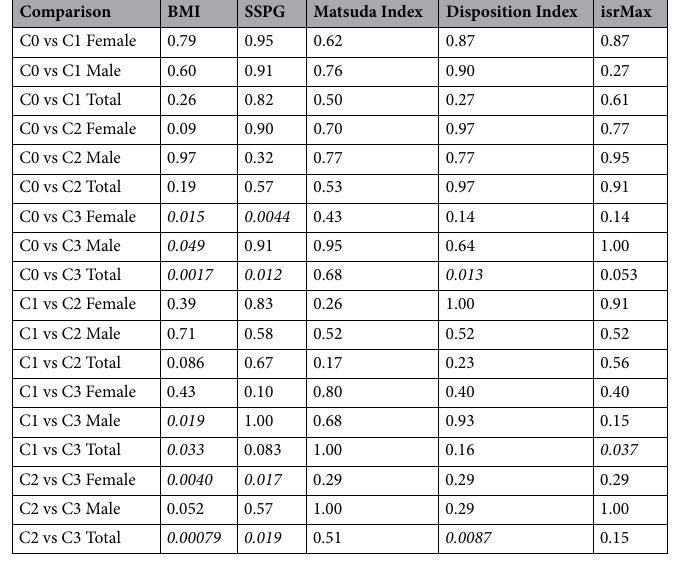
Table 3. Mann–Whitney U test for different measures between two different communities. The labels C0, C1, C2,C3 correspond to Community 0, Community 1 Community 2 and Community 3, respectively. Statistically significant ( p value < 0.05) results are shown in